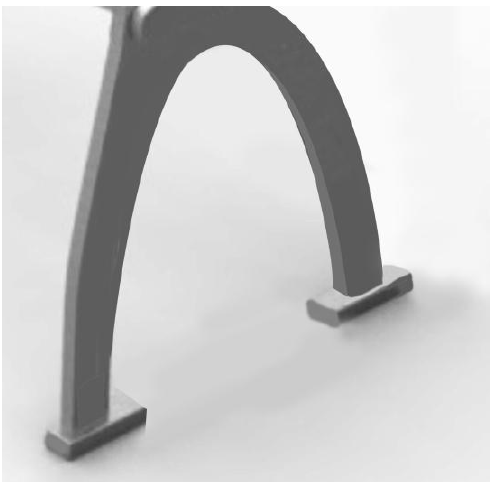
Figure 13. Traditional skeletal structure support. Designs 2017 , 1 , 11